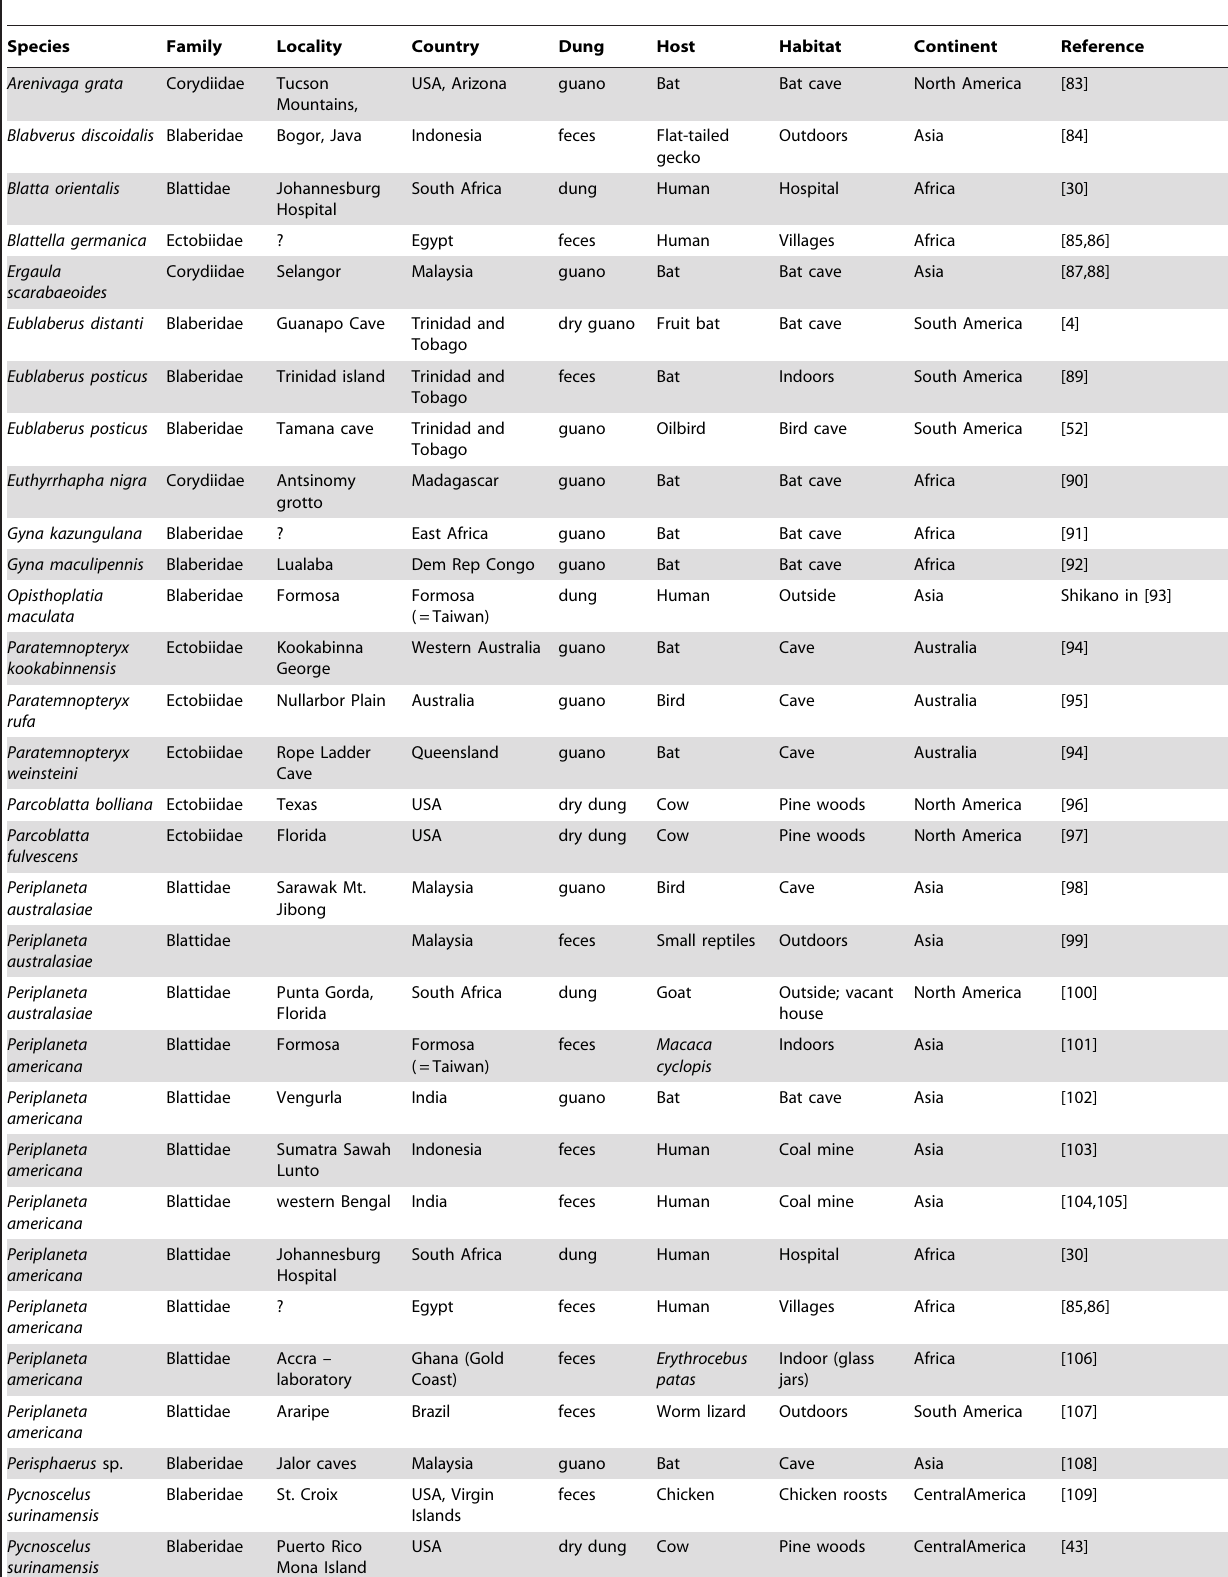
Table 1. Distribuition of living dung-feeding cockroaches supporting their common and cosmopolitan distribution [41], exclusively in dark (nocturnal, cave or under dung)